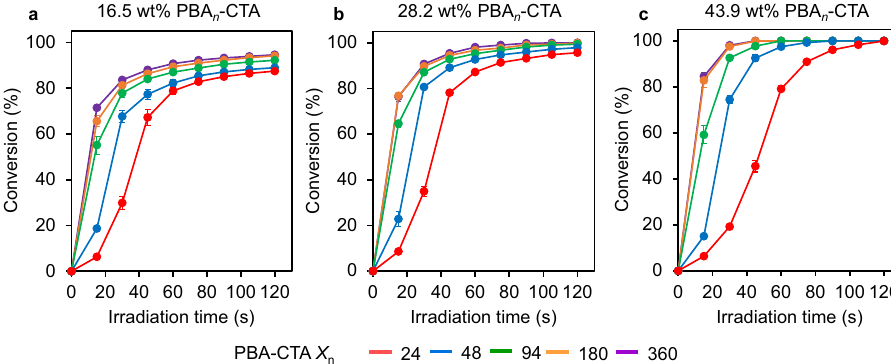
Fig. 2 Effect of PBA-CTA chain length on polymerization kinetics. The resins were formulated using a fi xed molar ratio of [AA]/[PEGDA] = 4/1 and a varied weight percentage of PBA-CTA as follows: a 16.5 wt%; b 28.2 wt%; c 43.9 wt%. X n – PBA-CTA degree of polymerization. The kinetics experiments were performed in triplicate. Double bond conversions were determined using ATR-FTIR under 2.06 mW cm − 2 violet light ( λ max = 405 nm). Error bars indicate standard deviation in triplicate measurements. Some error bars fall within the size of the